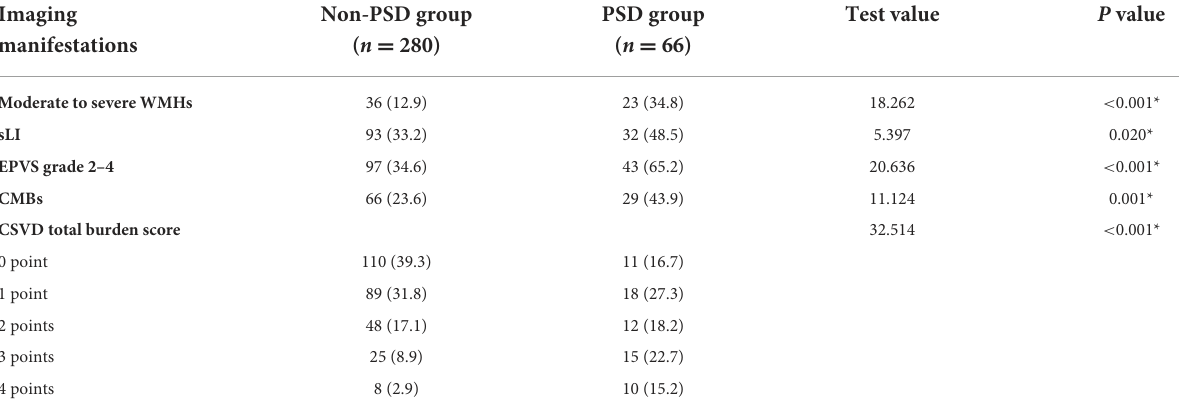
TABLE 2 The relationship between early-onset PSD and CSVD.